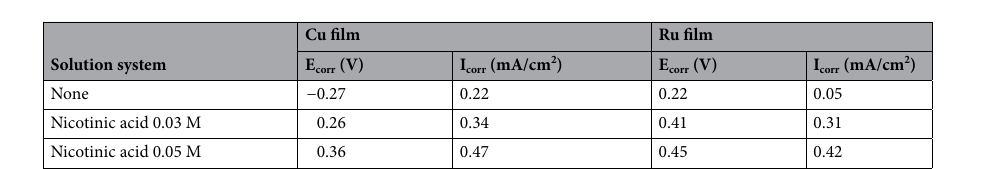
Table 1. The corrosion potentials (E corr ) and corrosion currents (I corr ) value of each Cu and Ru film according to inhibitor concentration.